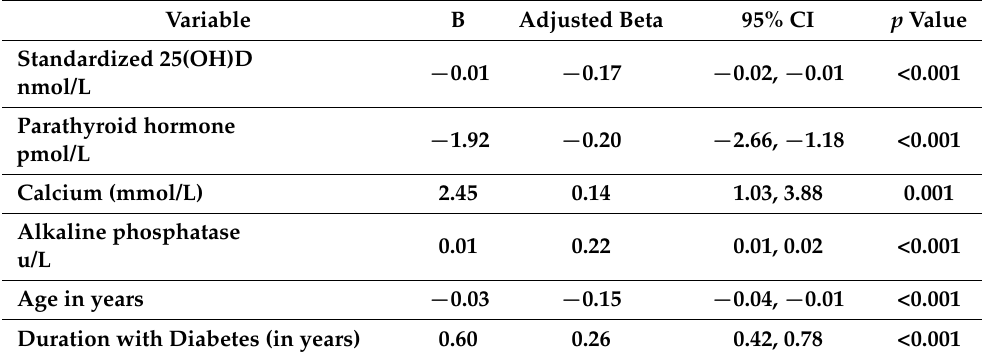
Table 3. Multivariable linear regression model * showing adjusted odds ratio and 95% confidence interval (CI) for the association between HbA1c and standardized 25-hydroxyvitamin in patients with diabetes in Riyadh, Saudi Arabia.